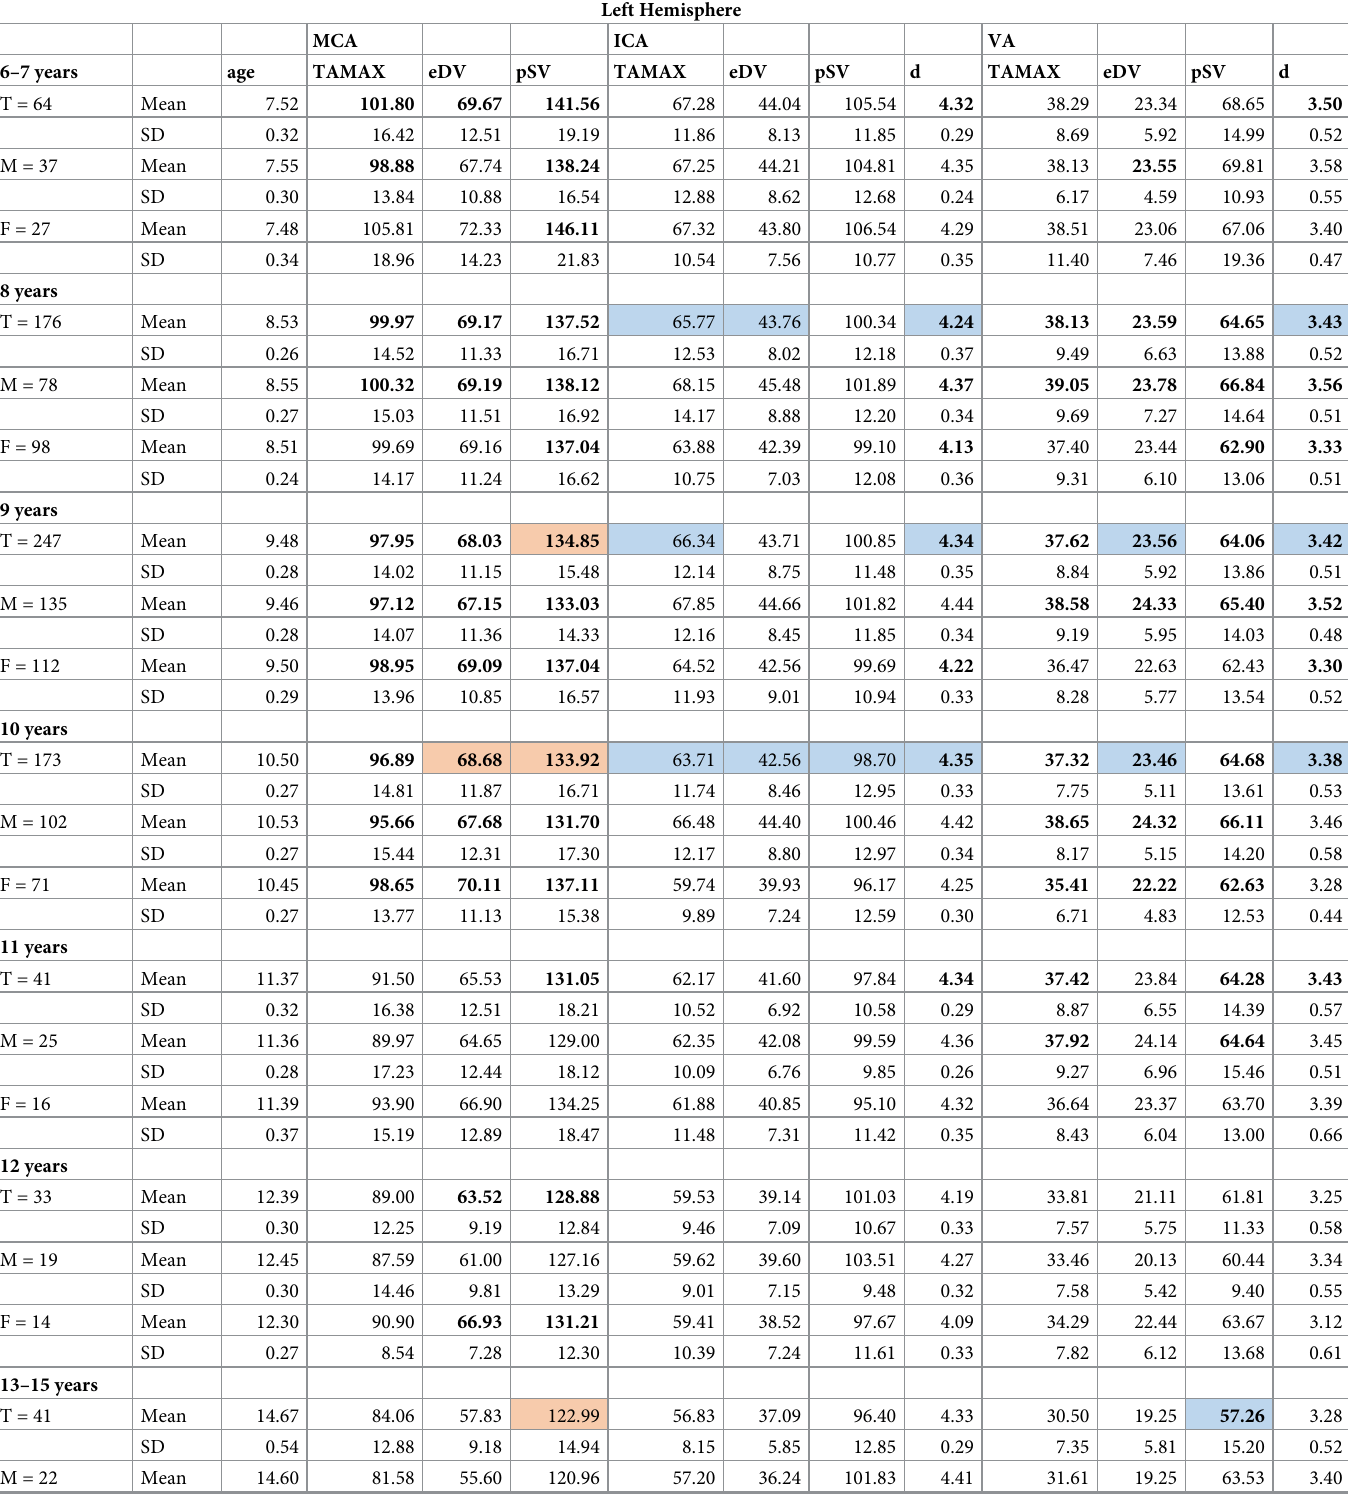
Table 1. Developmental metrics of cerebrovascular hemodynamics by age group, gender, and hemisphere. Left Hemisphere MCA ICA VA 6–7 years